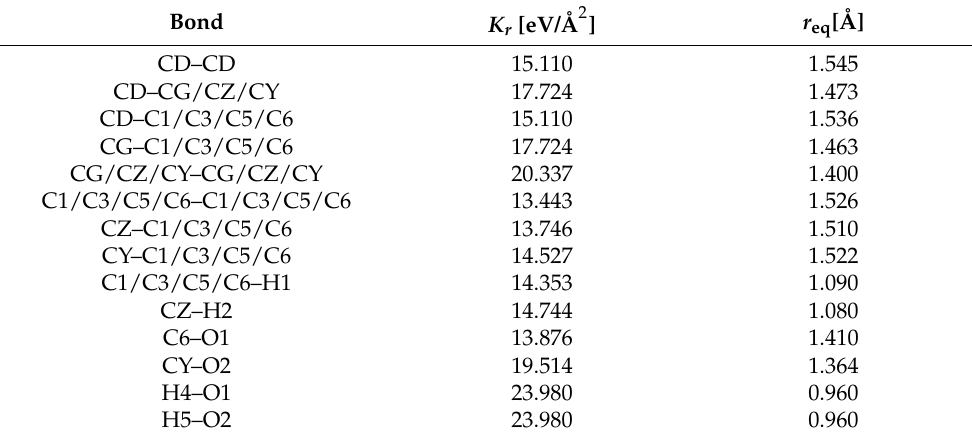
Parameters for atom pairs i - j interacting via harmonic bonds of the form